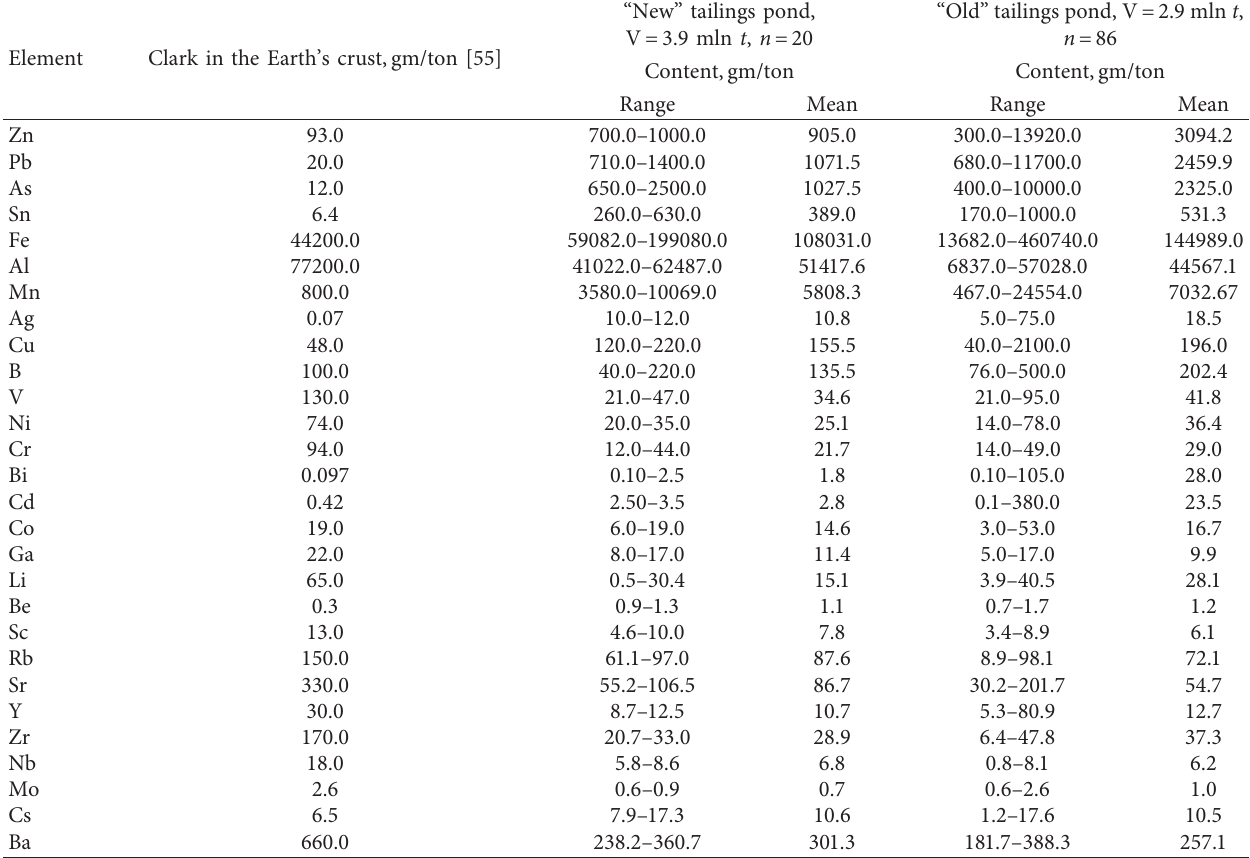
Table 1: The content of elements in the tailings of KCM.